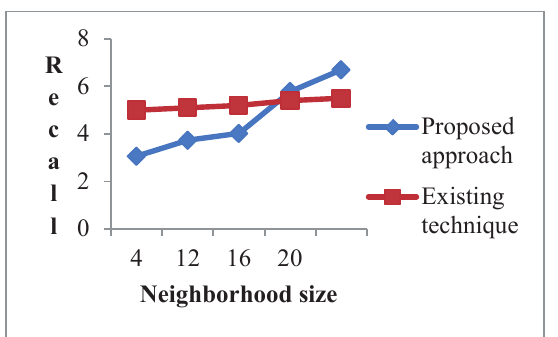
Fig 8. Neighborhood size vs